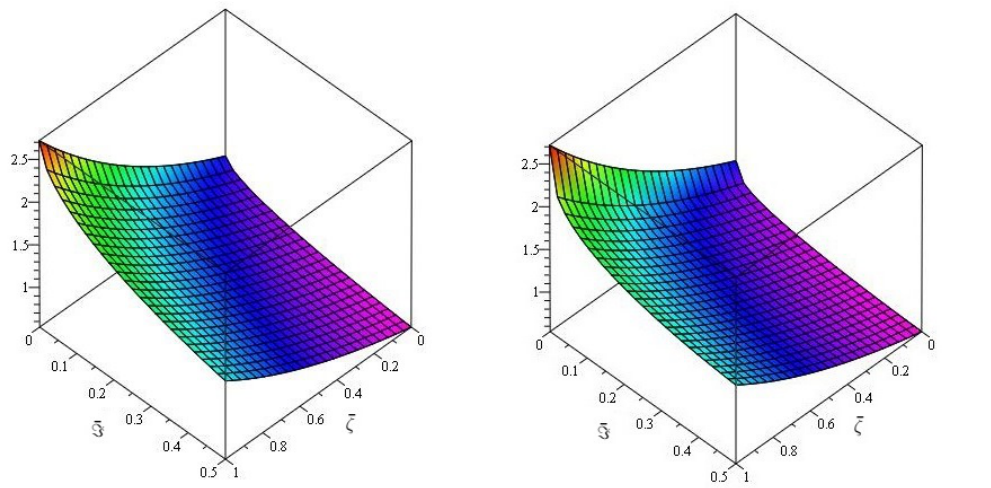
Figure 5. The first graph of analytical solution of β = 0.6 and second is β = 0.4 for Example 2.